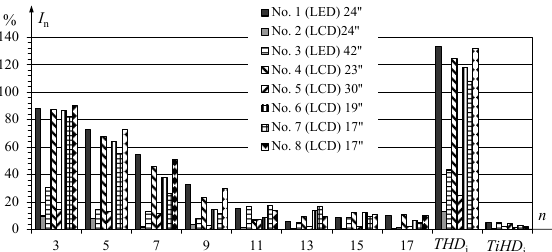
Fig.1. Percentage of higher current harmonics and THD I drawn from a low-voltage power grid by TV sets during operation.